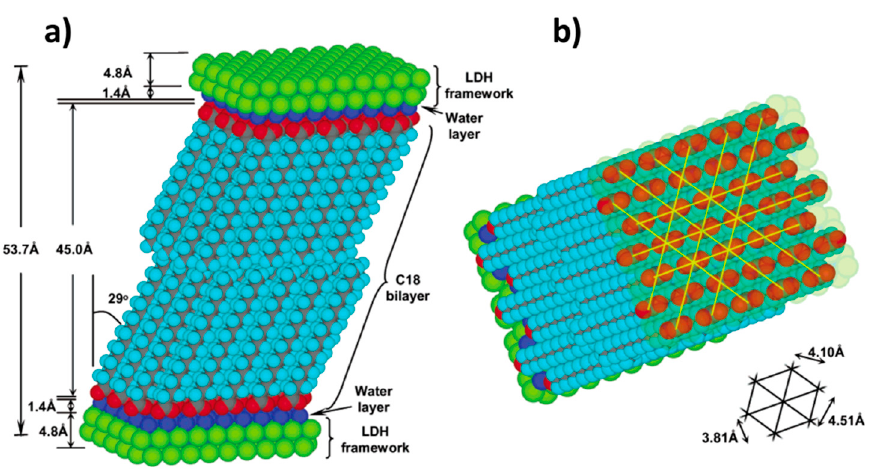
Figure 4. Scheme of stearate ions ordered layer assembly into LDH: ( a ) tilted bilayer, and ( b ) packing of stearate ions in the LDH framework. Reprinted with permission from Ref. [94] Copyright (2003) American Chemical Society.